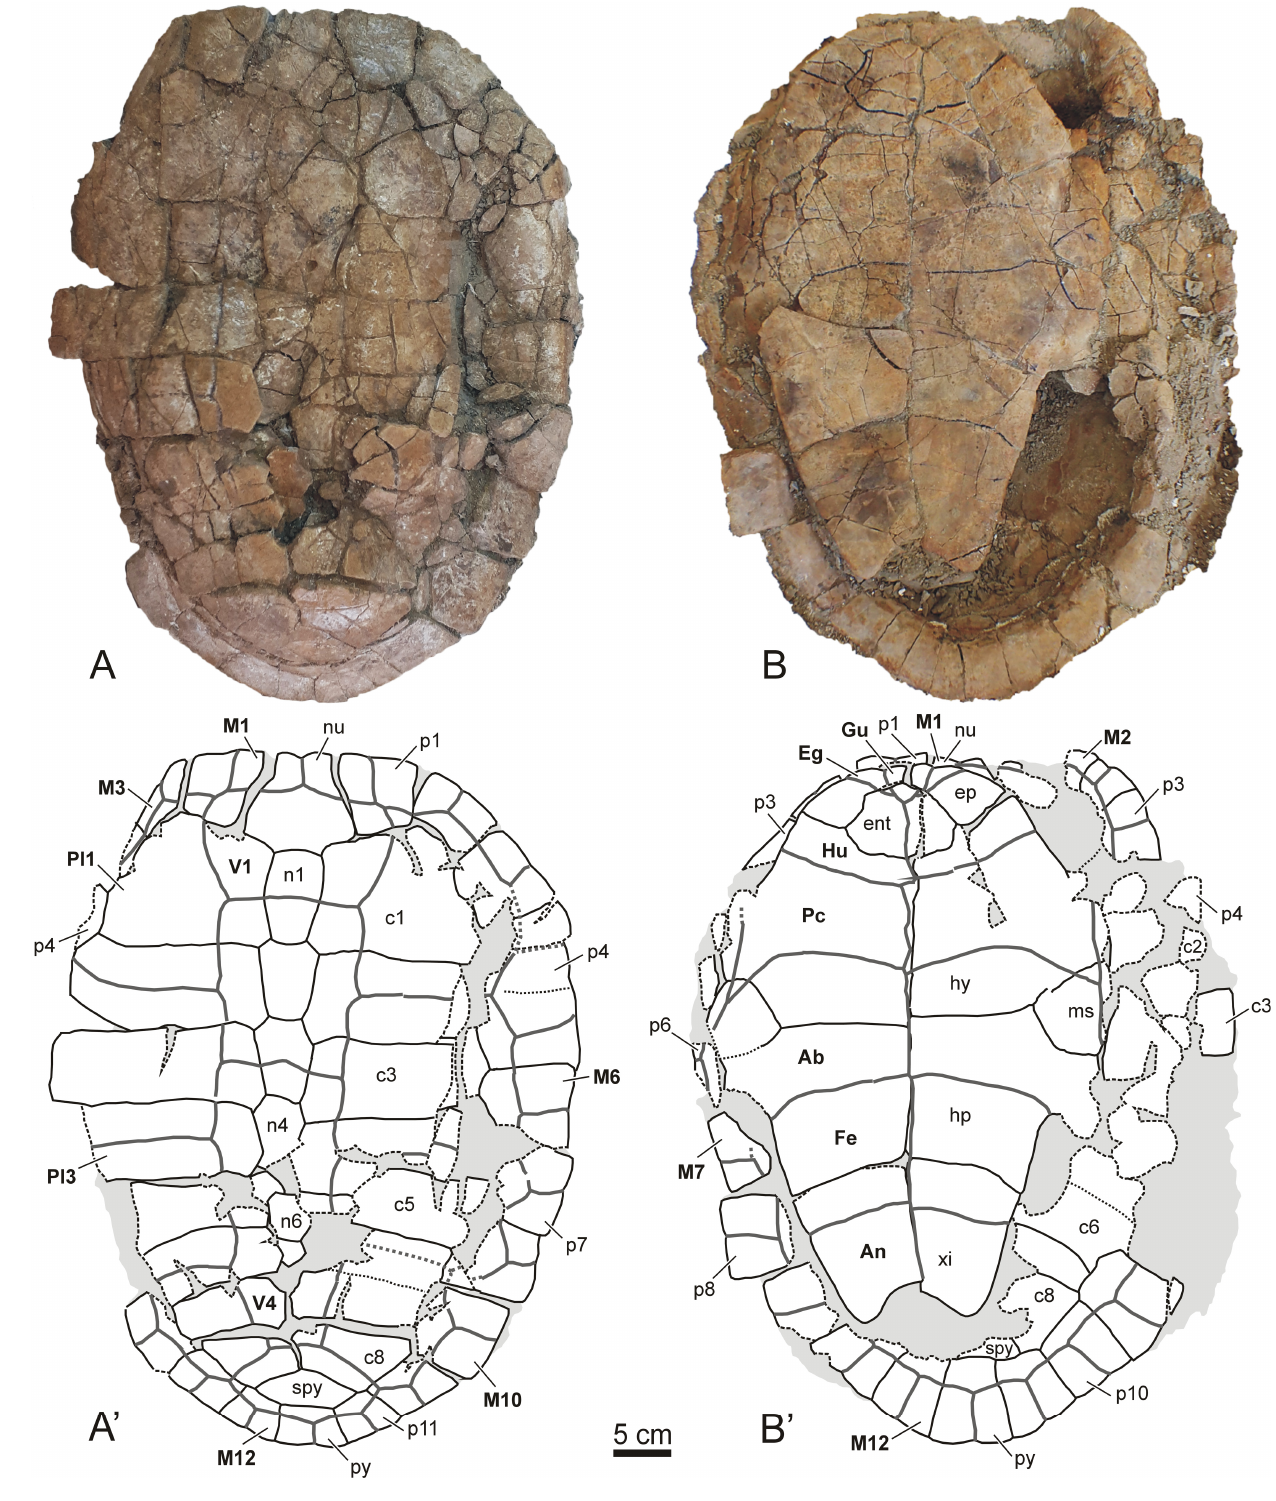
Figure 2. NVP005, the shell of the bothremydid turtle Khargachelys caironensis gen. et sp. nov., from the Campanian age of Kharga Oasis, South Western Desert, Egypt, in dorsal ( A , A’ ) and ventral ( B , B’ ) views.